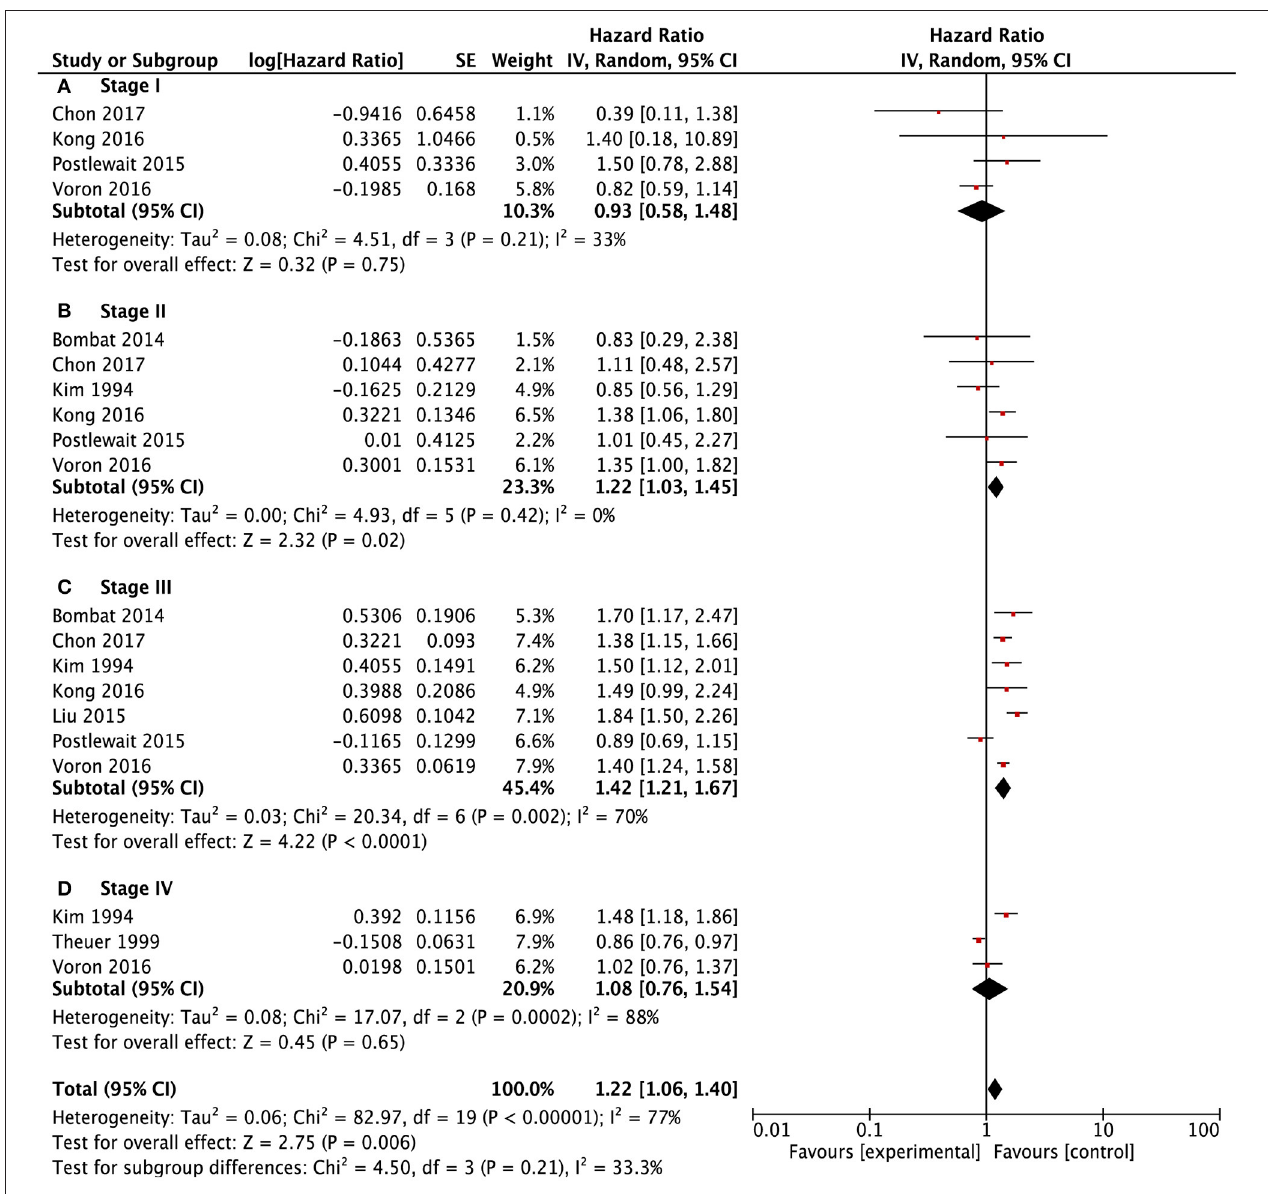
FIGURE 4 | Forest plots showing the survival outcomes of meta-analysis comparing different TNM stages been SRCC and NSRCC patients. (A) TNM Stage I. (B) TNM Stage II. (C) TNM Stage III. (D) TNM Stage IV.